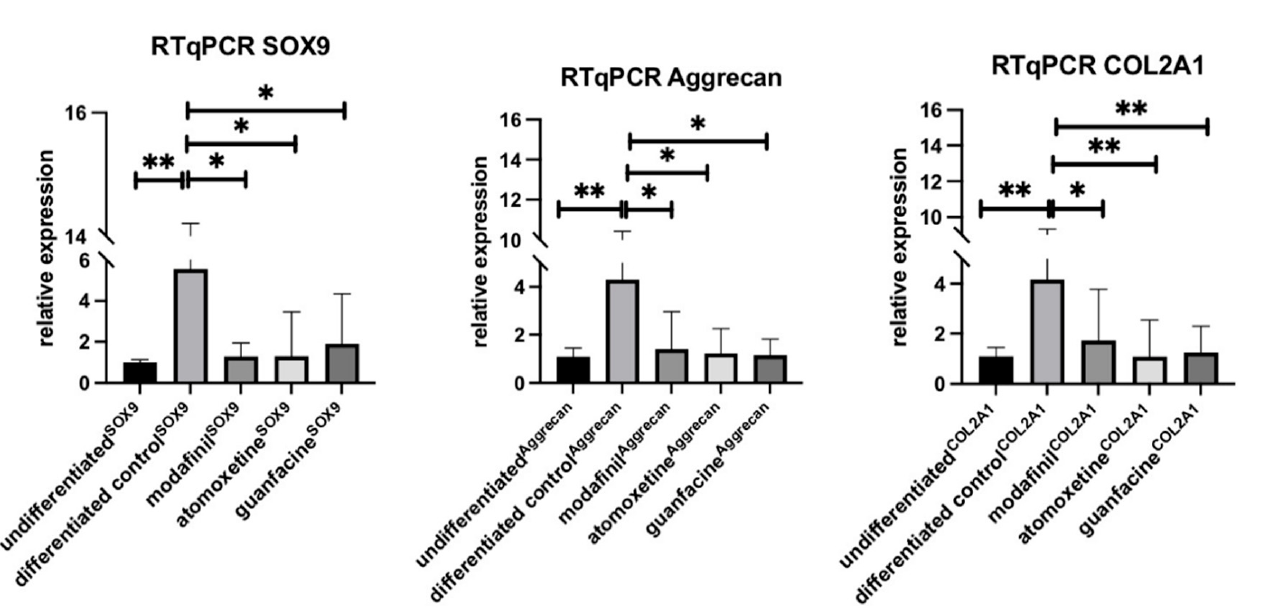
Figure 5. Expression of SOX9, Aggrecan and COL2A1 transcripts was determined in untreated, modafinil- (11.2 µg/mL), atomoxetine- (0.9 µg/mL) and guanfacine- (17.7 ng/mL) treated chondrogenic spheroids. Shown are means of normalized expression ± SD of three independent experiments with six biological replicates. The GAPDH transcript level was used to normalize the expression of the target genes. Significance in difference between the groups was determined by ANOVA followed by Tukey’s post hoc test. * corresponds to a value of p < 0.05. ** corresponds to a value of p < 0.01.